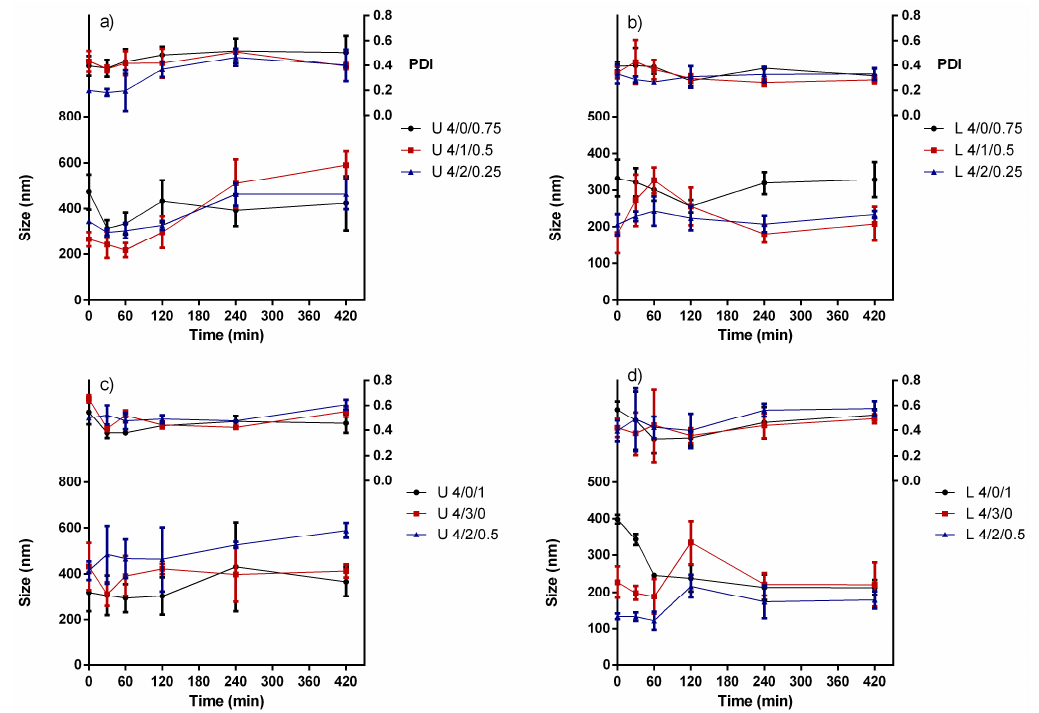
Figure 6. Stability of selected unloaded and quercetin-loaded nanoparticles of CS 70/5 ( a , b ), and CS 70/20 ( c , d ) in M9 medium at 37 °C (mean ± S.D., n = 3) at varying mass ratios of CS/SBE β CD/TPP shown in labels (L: loaded NPs; U: unloaded nanoparticles).